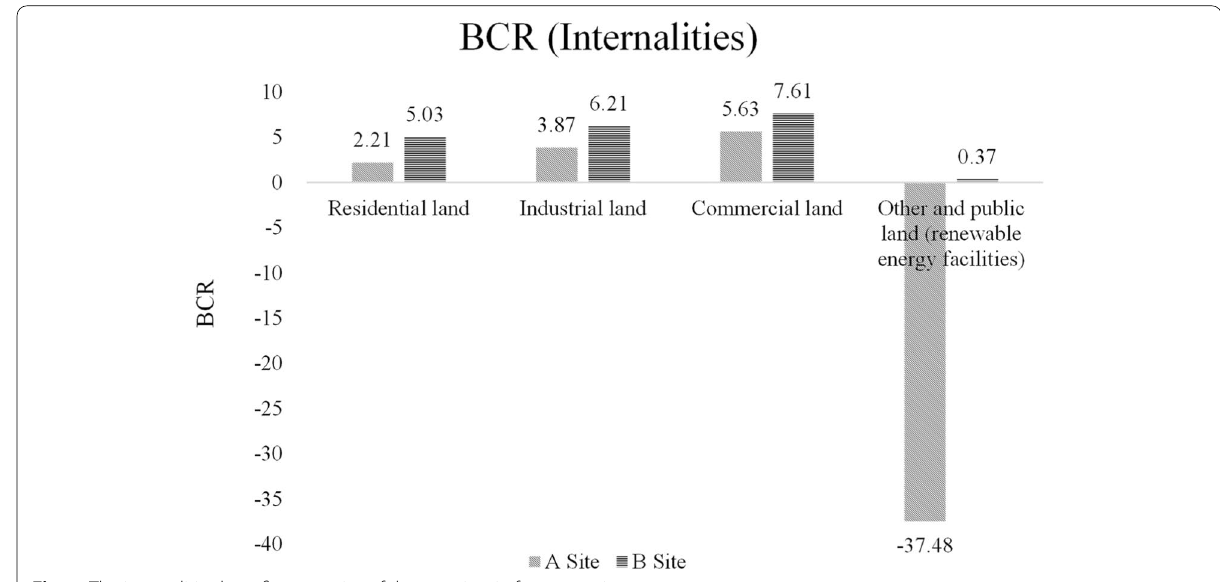
Fig. 7 The internalities benefit‑cost ratios of the two sites in four scenarios